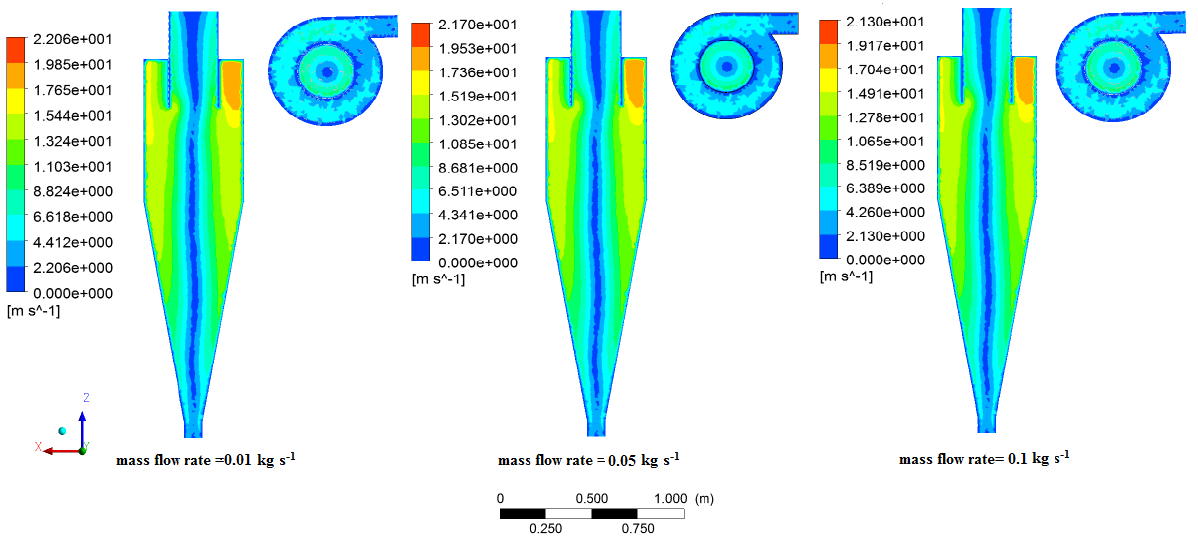
Figure 11. Tangential velocity contours in various mass flow rates.